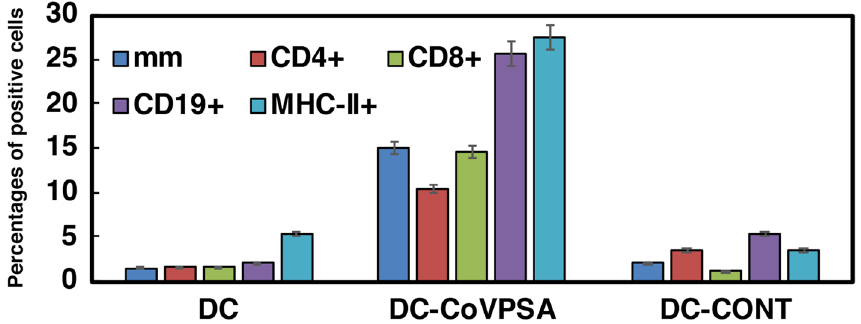
Figure 2. Immunogenicity of the CoVPSA peptide in vaccine platforms. The hind footpads of mice (C57BL/6, n = 5) were inoculated with the DC vaccine (10 6 cells/mouse) loaded with different peptides (COVID-CoVPSA or peptide control, CONT) or remained as empty DCs in formulations with the adjuvant DIO-1 (40 ng/mL). After 48 hours, footpad swelling was measured with a caliper (dark blue bars) and expressed as the difference in mm between left and right hind footpads. Results are the mean ± SD of three different experiments (* P < 0.05). Popliteal lymph nodes were then isolated from the legs of the mice and after homogenization, immune cell populations were analyzed by flow cytometry. The percentages of CD4 + (red bars), CD8 + T cells (green bars), CD19 + (B cells, purple bars), and MHC-II + positive cells, mainly DCs or macrophages (light blue bars), are shown. Results are expressed as the percentage of positive cells ± SD of three different experiments ( P < 0.05). Experiments were performed six times.